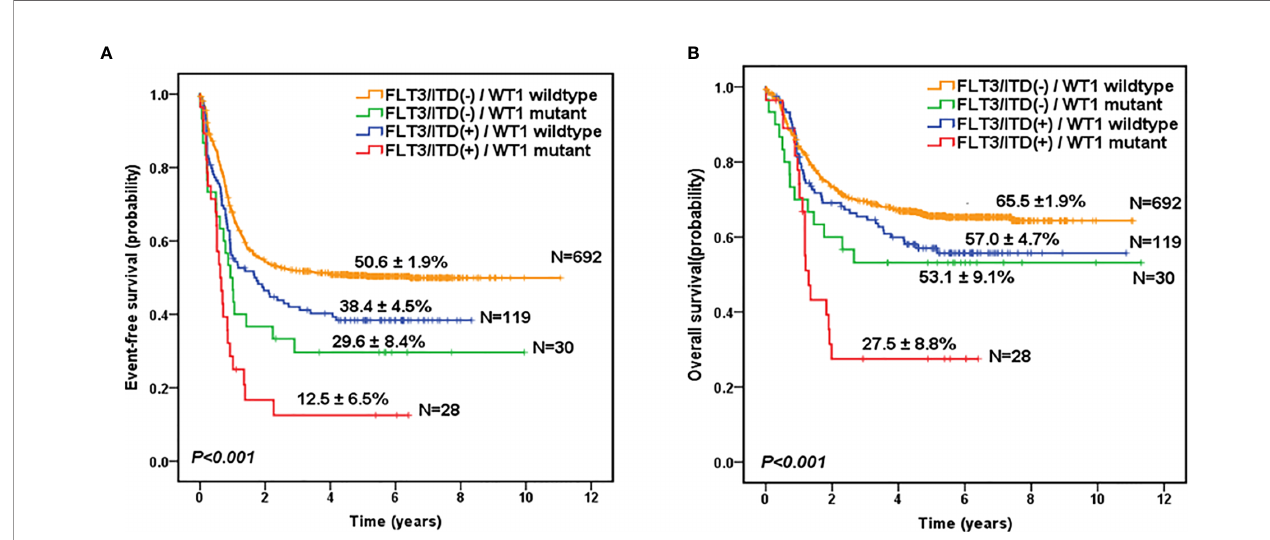
FIGURE 2 | Survival curves of all pediatric AML patients according to the combined WT1 mutations and positive FLT3/ITD status. Probability of EFS (A) and OS (B) for patients according to the combined WT1 mutations and positive FLT3 /ITD status, respectively.